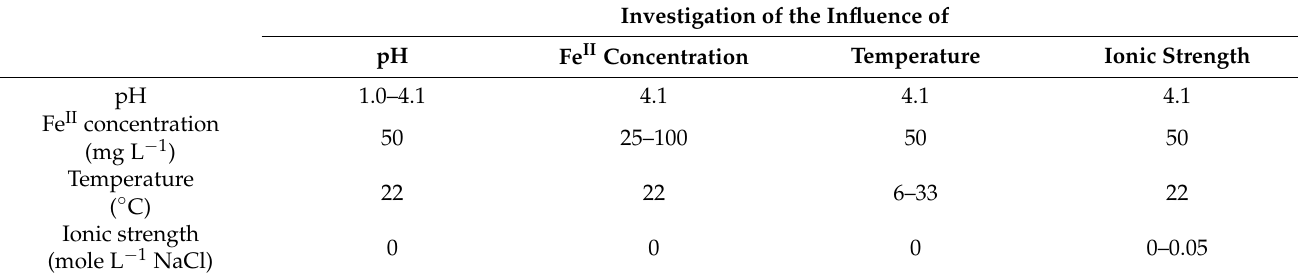
Table 3. Setup design of AMD treatability experiments .